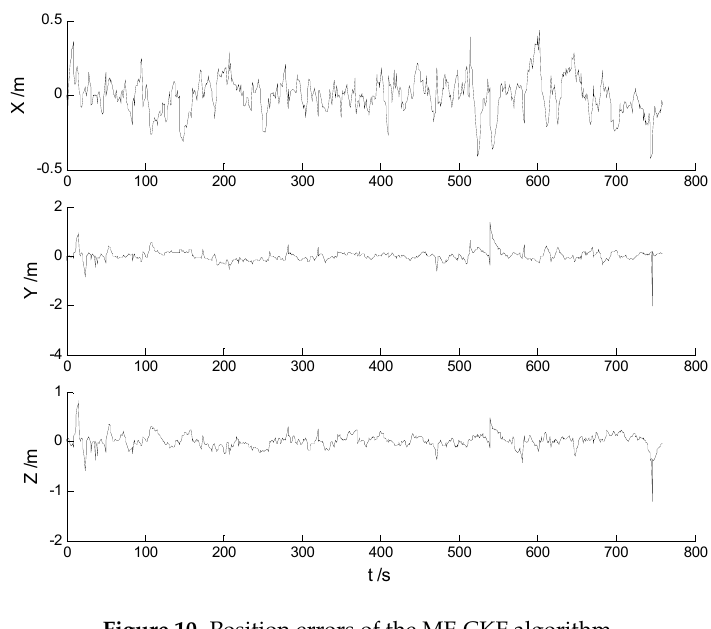
Figure 10. Position errors of the MF-CKF algorithm.